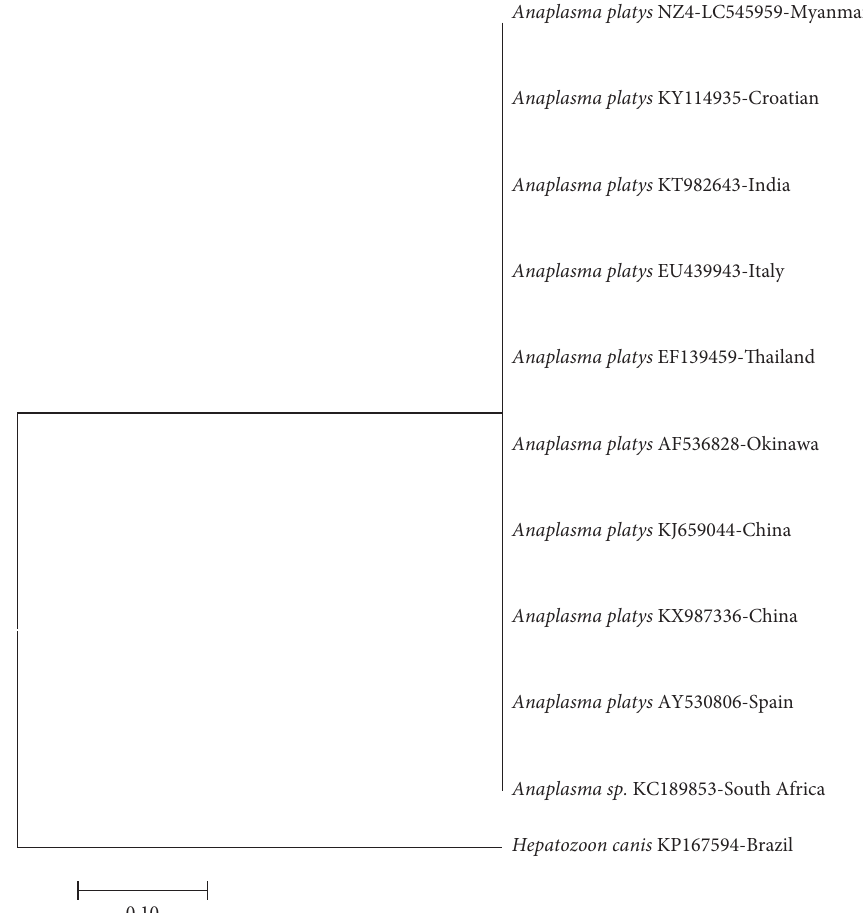
Figure 4: Phylogenetic tree based on the Anaplasma 16S rRNA sequence. Sequences from the Anaplasma genera were compared with the neighbor-joining method with distance matrix calculation by Kumar-two parameters, operated by MEGA software (version 7), using Hepatozoon canis as the outgroup. Scale bar indicates the number of mutations per sequence position. The numbers at the nodes represent the percentage of 1000 bootstrap